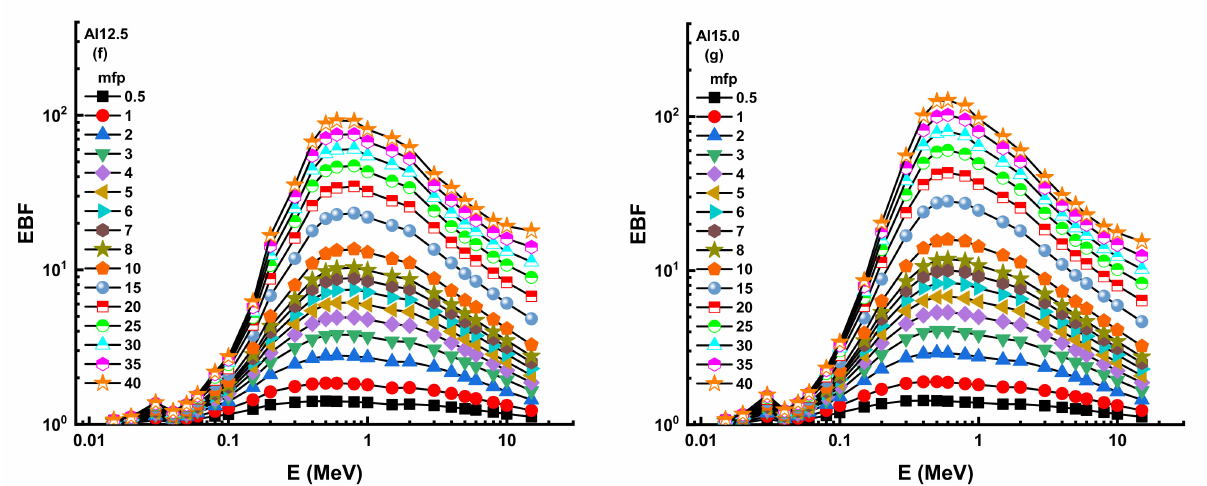
Figure 10. Variation of exposure buildup factor (EBF) against photon energy for all glasses. ( a ) AL0.0; ( b )AL2.5; ( c )AL5.0; ( d ) AL7.5; ( e ) AL10.0; ( f ) AL12.5; ( g ) AL15.0.